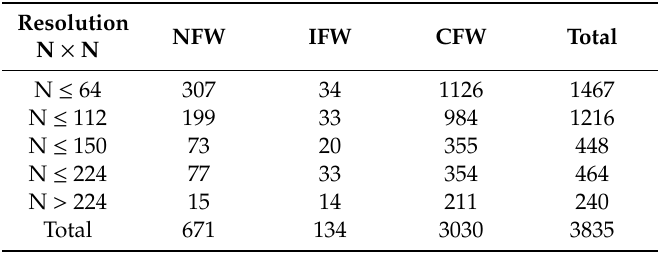
Table 1. Image resolution